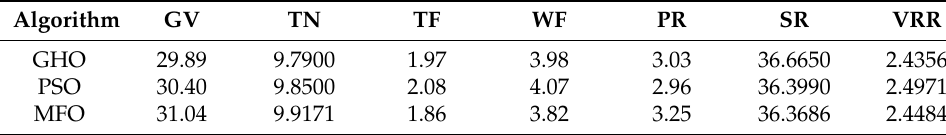
Table 10. Optimized parameters and its responses.